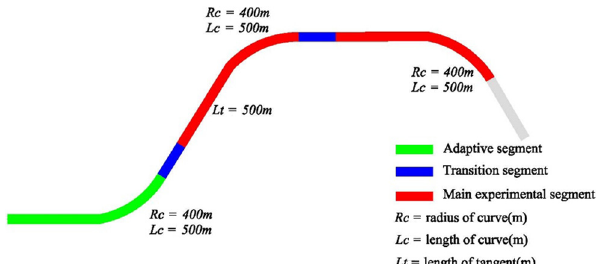
Figure 2 Experiment